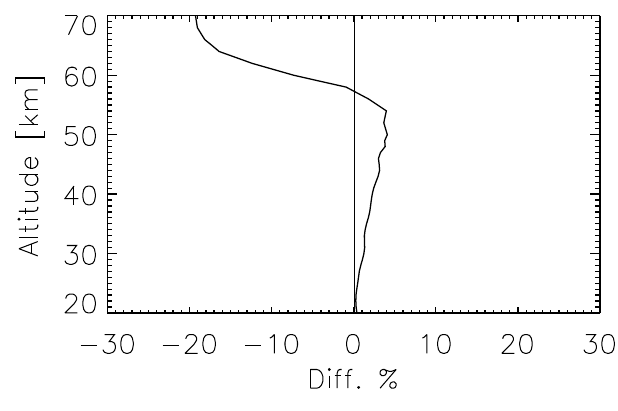
Fig. 15. Mean difference between MIPAS LTE and non-LTE water vapor daytime retrievals at mid-latitudes. About 100 profiles have been averaged.